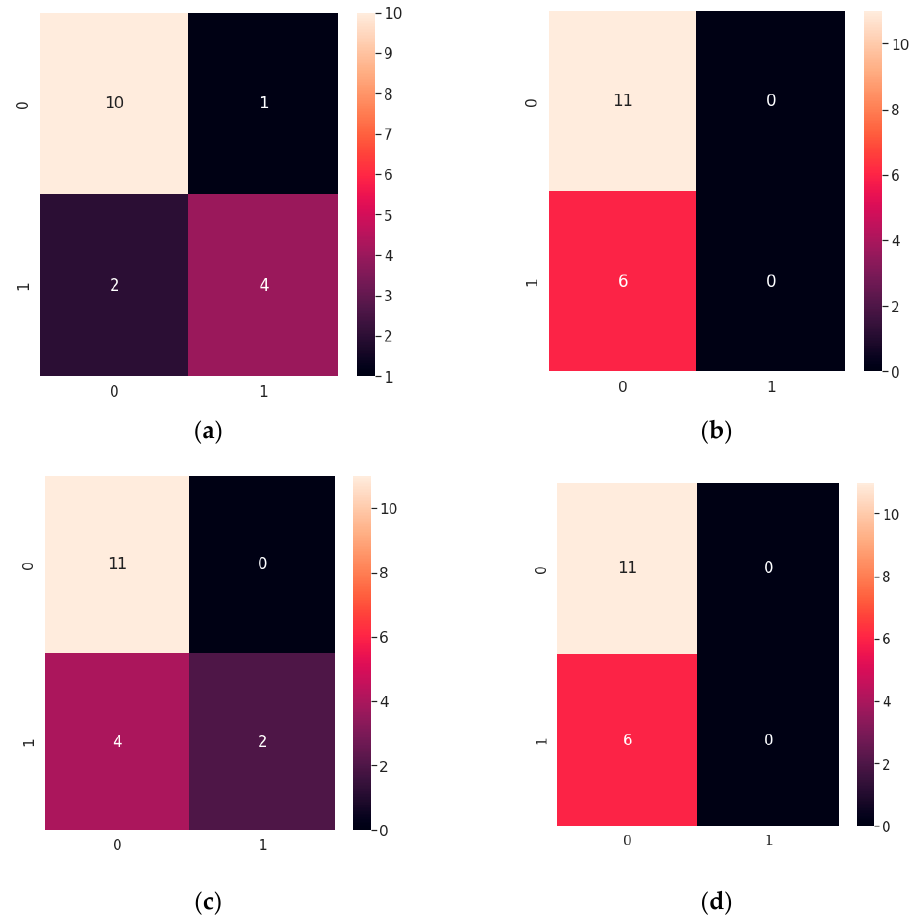
Figure 6. Confusion matrix of ( a ) logistic classification, ( b ) decision tree, ( c ) random forest, and ( d ) AdaBoost.